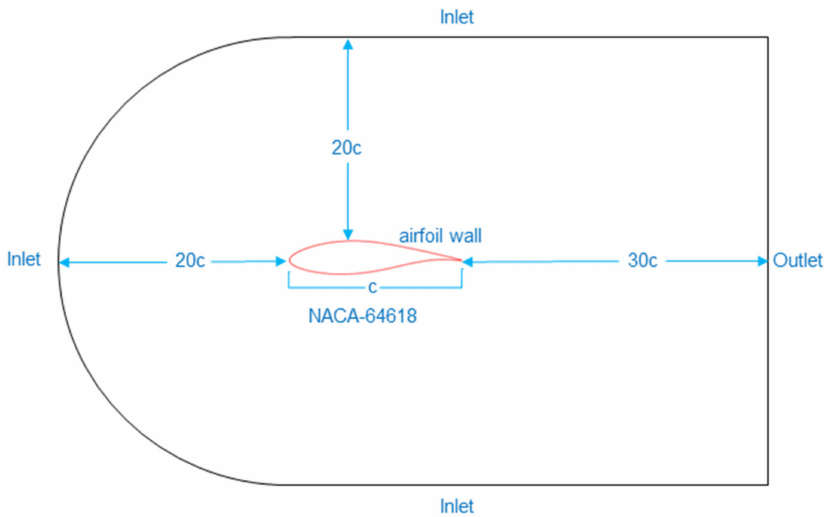
Figure 1. The geometry of the computational domain. Airfoil size is exaggerated for clarity.